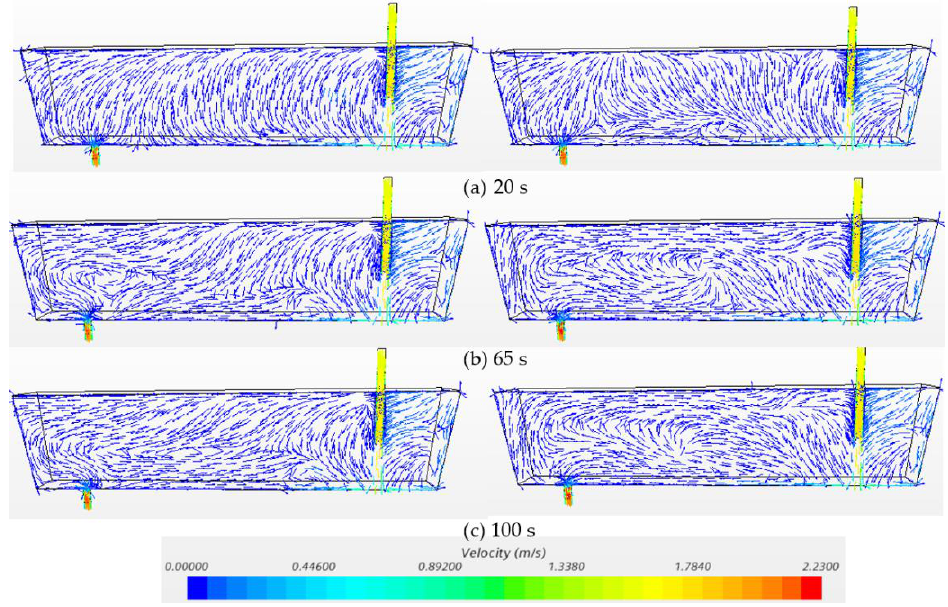
Figure 8. Velocity at symmetry plane under transient non-isothermal conditions in bare water model (Q = 2000 L/h, H = 0.4 m, left: ΔT = 20 °C, right: ΔT = −20 °C). ( a ) 20 s, ( b ) 65 s, ( c ) 100 s.